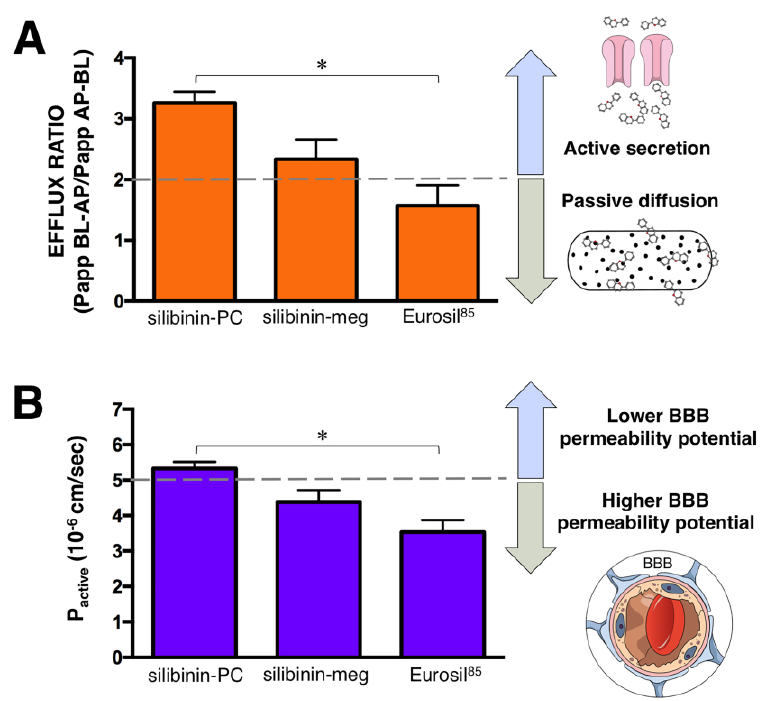
Figure 2. Transport ratios of the different formulations of silibinin . ( A ) Efflux ratio (P app ) BL – AP/P app AP – BL). ( B ) Blood – brain barrier (BBB) permeability-related P active ratio ([P app BL – AP - P app AP – BL]/2). * One-way ANOVA p < 0.0001; silibinin-PC: silibinin-phosphatidylcholine; silibinin-meg: